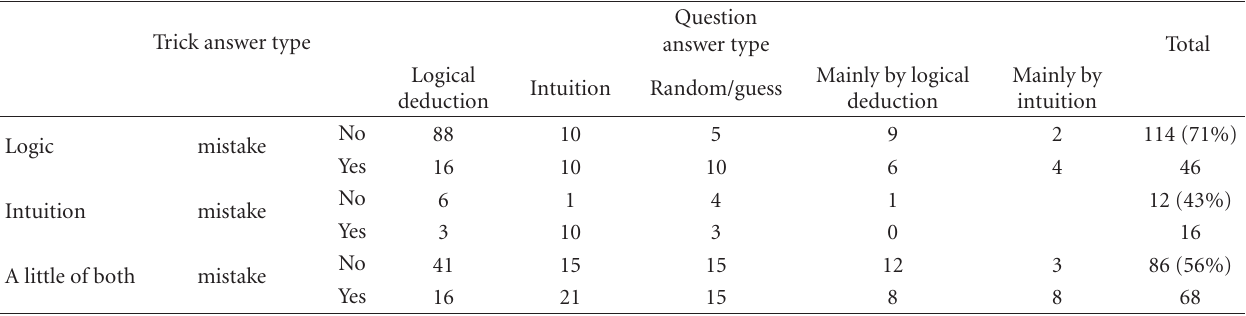
Table 4: Mistake ∗ question answer type ∗ trick answer type crosstabulation.